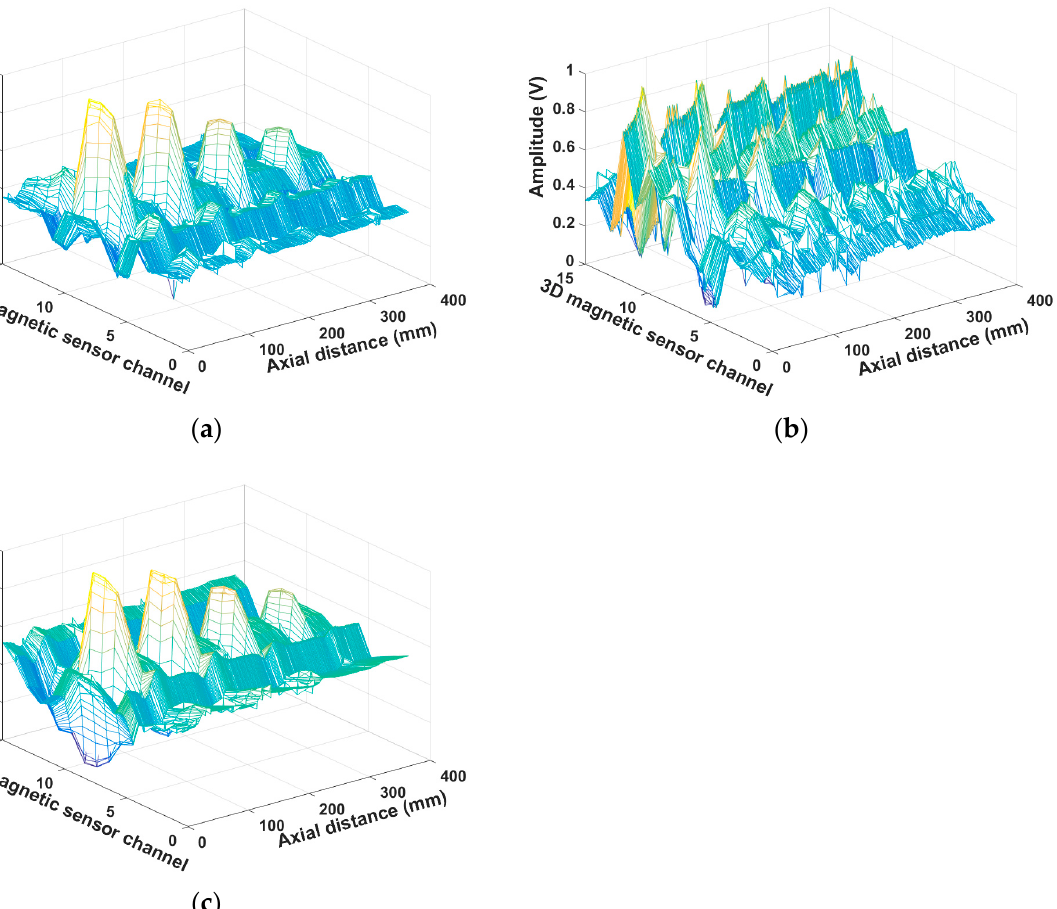
Figure 4. 3D MFL signals of 15 channels before noise reduction. ( a ) x axis before noise reduction; ( b ) y axis before noise reduction; ( c ) z axis before noise reduction.